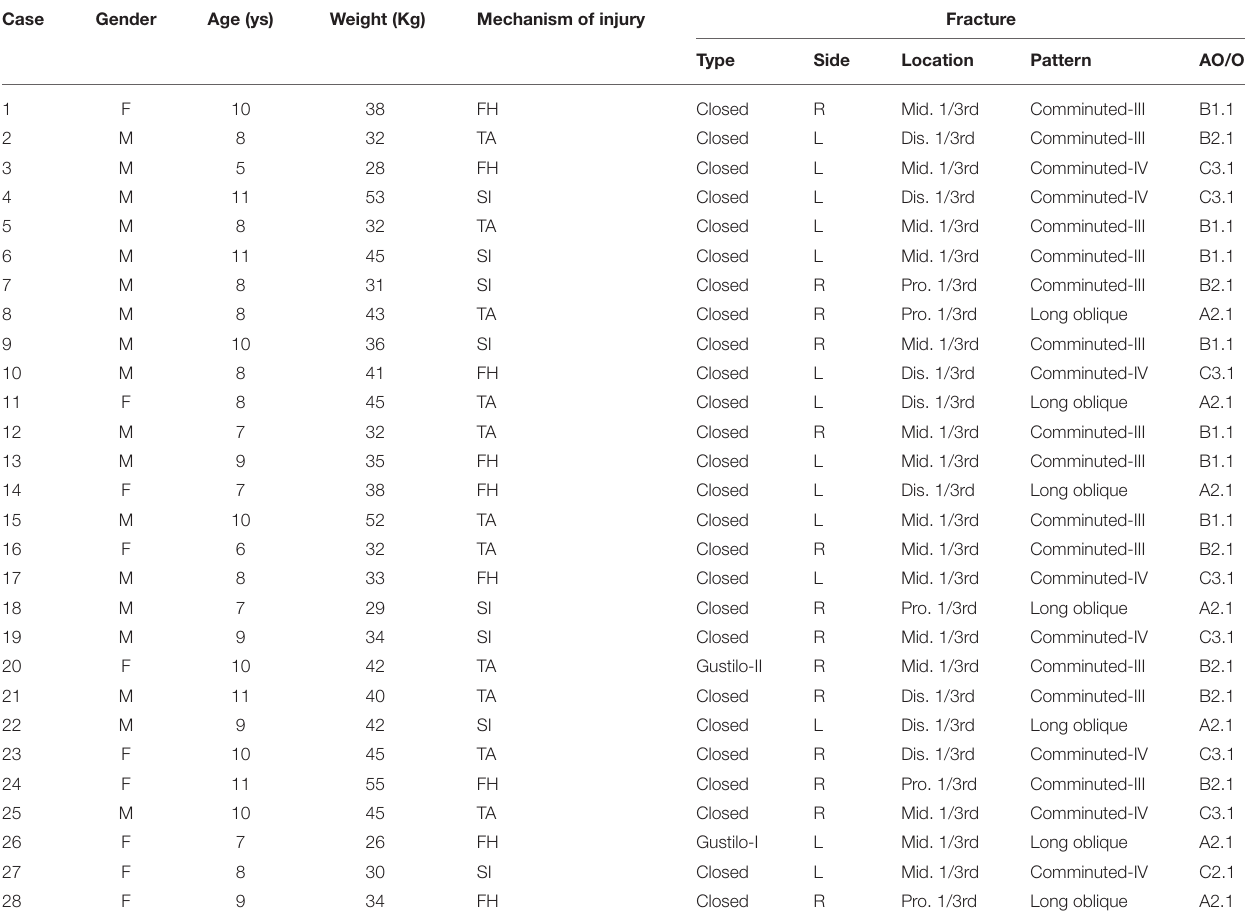
TABLE 3 | Demographic of